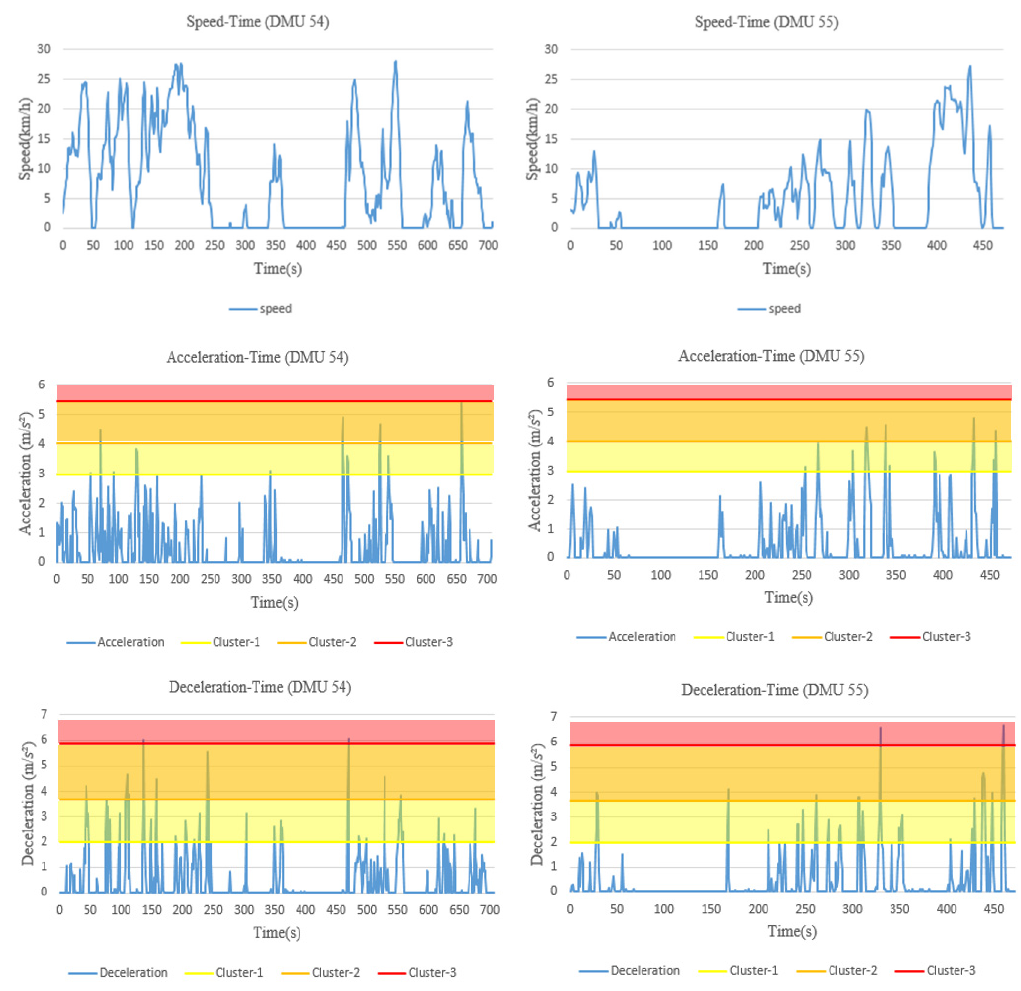
Figure 3. The driving behavior data of DMUs 54 and 55.